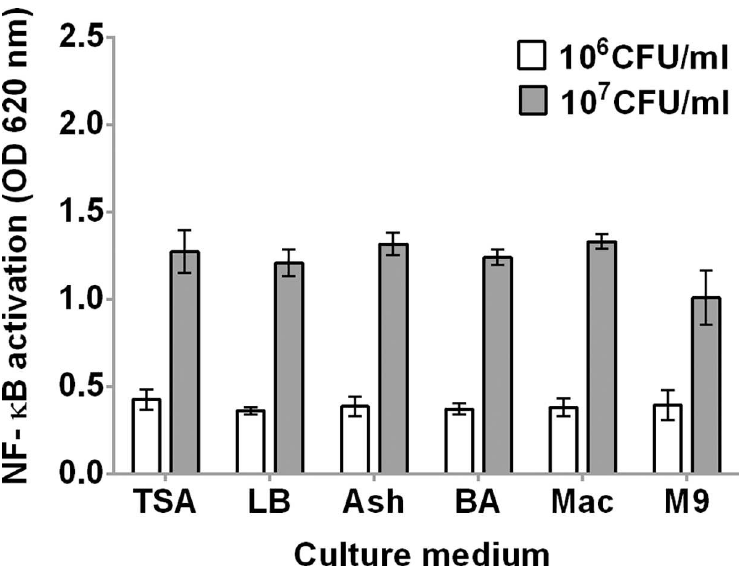
Fig 6. Activation of NF- κ B in HEK-Blue hTLR4 cells by B . pseudomallei K96243 cultured in different media. HEK-Blue hTLR4 cells were stimulated with heat-killed B . pseudomallei K96243 at 10 6 or 10 7 CFU/ml at 37˚C in 5% CO 2 for 24 h. NF- κ B activation was determined in the supernatant by a SEAP reporter assay with HEK-Blue detection. Mean ± SD of three independent experiment were illustrated. TSA; trypticase soy agar, LB; Luria-Bertani agar, Ash; Ashdown agar, BA; Blood agar, Mac; MacConkey agar, M9; M9 minimal medium agar. LPSs of all isolates induced a significant increase of NF- κ B activation in HEK-Blue hTLR4 cells above the baseline level in dose-dependent manner (Fig 8). Our results showed no signifi- cant difference among different B . pseudomallei isolates in TLR4-dependent NF- κ B activation in cells stimulated with LPSs at 1 ng/ml ( P = 0.68), 10 ng/ml ( P = 0.14), 100 ng/ml ( P = 0.33), 1000 ng/ml ( P = 0.28) or 10,000 ng/ml ( P = 0.29). Activation of human TLR4 by heat-killed B . pseudomallei OPS and capsule mutants Although lipid A is the ligand for TLR4 [35], we hypothesized that there may be an effect of the OPS component of the LPS on this interaction. To investigate whether the presence of OPS on B . pseudomallei cells was associated with altered TLR4 signaling, we stimulated HEK-- Blue TM -hTLR4 cells with heat-killed wild type K96243 and OPS mutant strains containing unmarked deletions of wbiD , wbiA , and oacA , which are involved in B . pseudomallei OPS bio- synthesis [30]. We have previously shown that–like wild type B. pseudomallei K96243 –K96243 Δ wbiA and Δ oacA have type A ladder patterns, whereas K96243 Δ wbiD completely lacks OPS [30]. As shown in Fig 9, NF- κ B activation was significantly higher in cells stimulated with 10 6 ( P < 0.001) and 10 7 ( P < 0.01) CFU/ml of B . pseudomallei K96243 Δ wbiD compared to those of wild type. We demonstrated no significant difference in TLR4-dependent NF- κ B activation in cells stimulated with heat-killed bacteria obtained from B . pseudomallei K96243 Δ wbiA and Δ oacA compared to wild type at 10 6 CFU/ml or 10 7 CFU/ml. These data show that the absence of OPS does permit enhanced TLR4 signaling by heat killed B . pseudomallei . To further test whether the presence of capsule of B . pseudomallei cells interfered with TLR4 signaling, we stimulated HEK-Blue TM -hTLR4 cells with heat-killed wild type strain 4095a and a mutant containing unmarked deletions of wcbB (4095a Δ wcbB ), which is involved in B . pseudomallei capsule biosynthesis [30]. Confirmatory testing with latex agglutination,